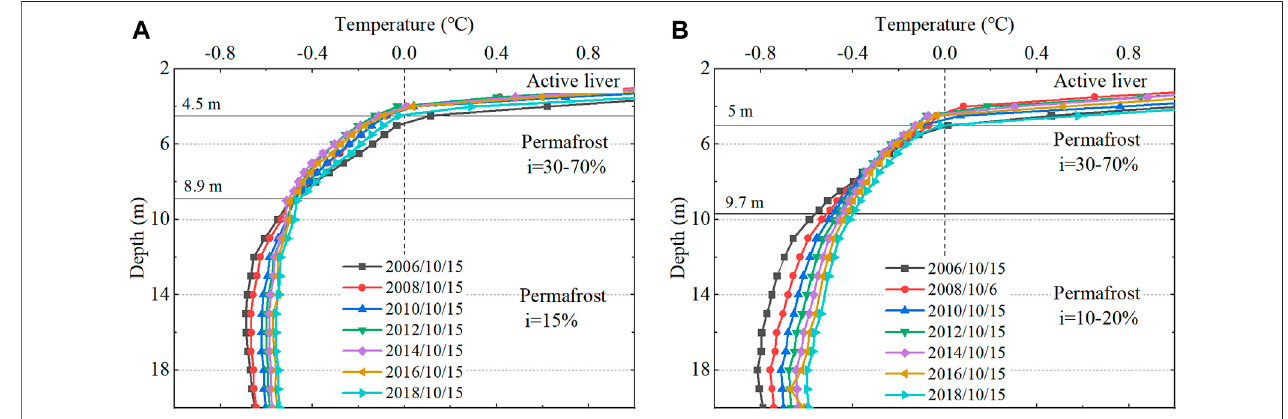
FIGURE 11 | Ground temperature pro fi les in mid-October in different years of the UCRE (A) and CRRE (B) . i: Volume ice content (%).